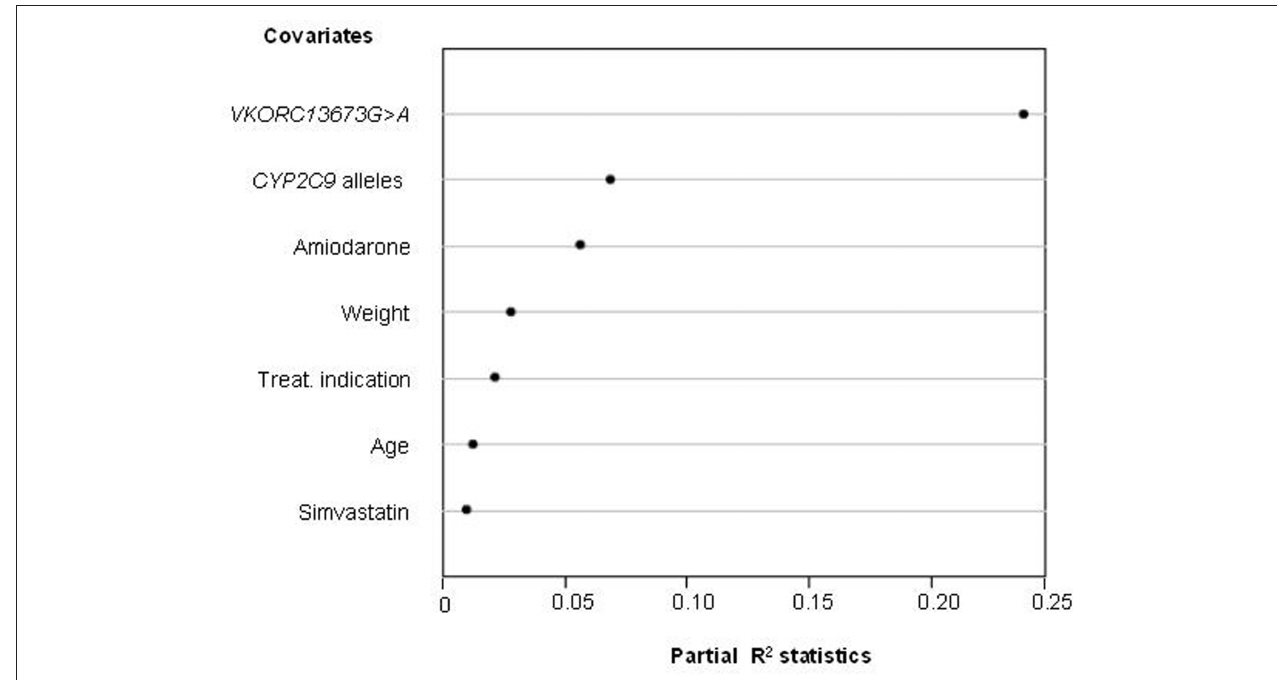
to the final model is expressed by the partial R 2 statistics (abscissa), which measures the degree of association between two random variables, with the effect of a set of controlling random variables removed. The higher the R 2 value, the greater the contribution of the covariate to the model. Data from Perini et al.